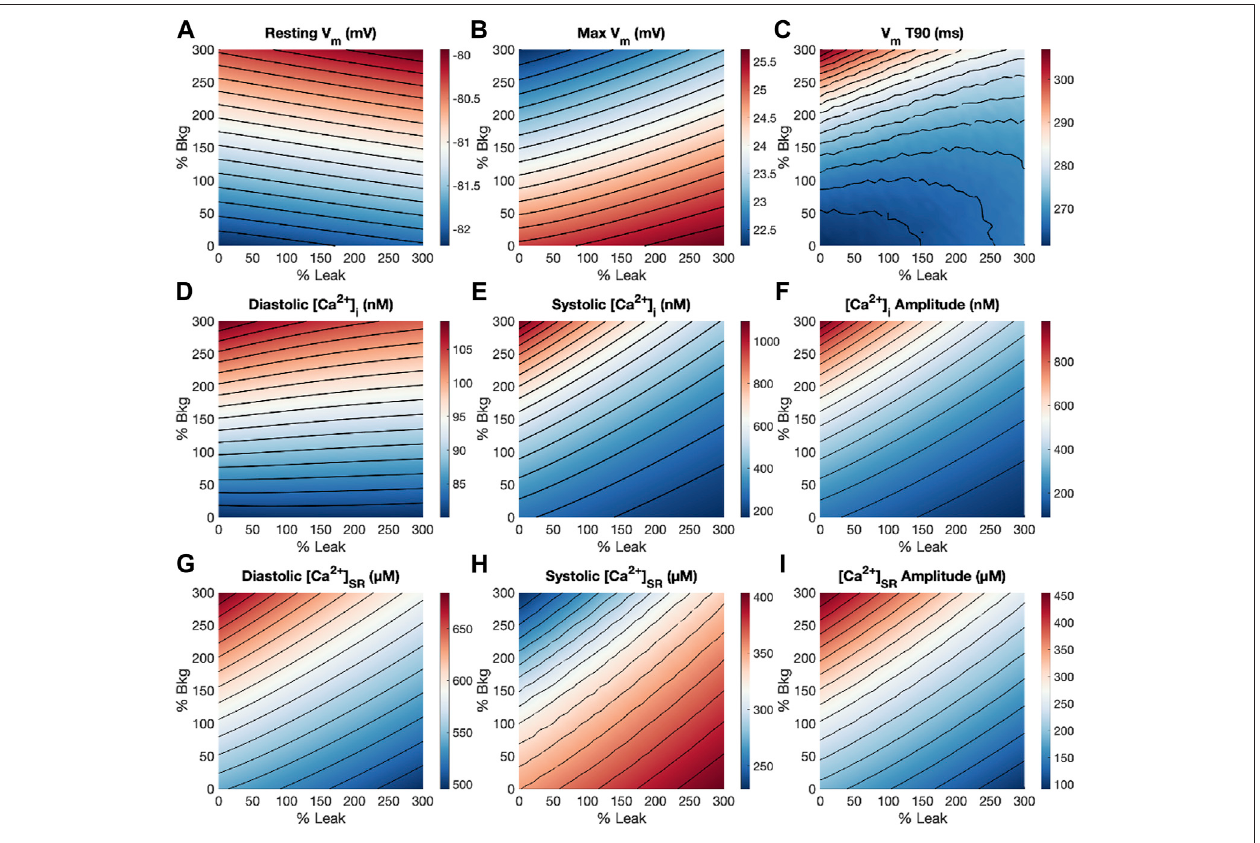
FIGURE7| Dual-parametersensitivityanalysisofmodulatingG bkg andK leak at1 Hzpacing.Surfaceplotswithcontourlinesformeasurementsof (A) restingV m , (B) maximum V m , (C) APD 90 , (D) diastolic [Ca 2+ ] i , (E) systolic [Ca 2+ ] i , (F) [Ca 2+ ] i amplitude, (G) diastolic [Ca 2+ ] SR , (H) systolic [Ca 2+ ] SR , and (I) [Ca 2+ ] SR amplitude.